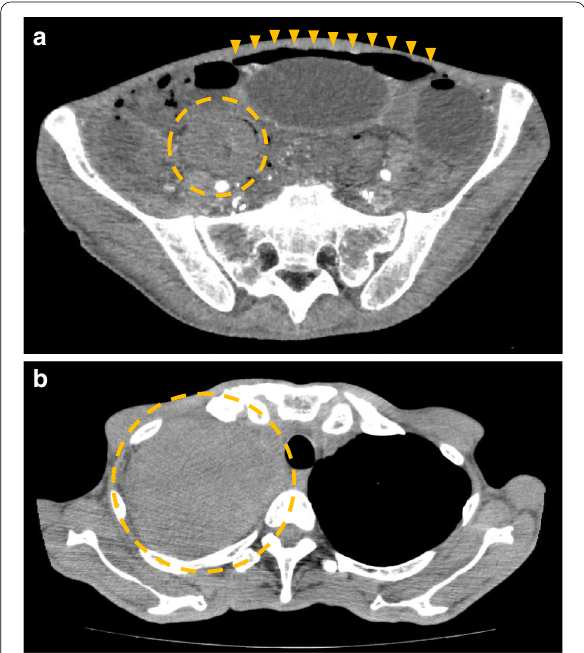
Fig. 1 Computed tomography findings. a Intestinal ischemia was noted in almost all intestinal tracts. Extensive free intra-abdominal gas was noted in the upper and lower abdomen (arrowheads). Intestinal pneumatosis and intussusception of the small intestinal tumor were noted in the right lower abdomen (circle). b A large mass was found in the upper right lobe of patient’s lung